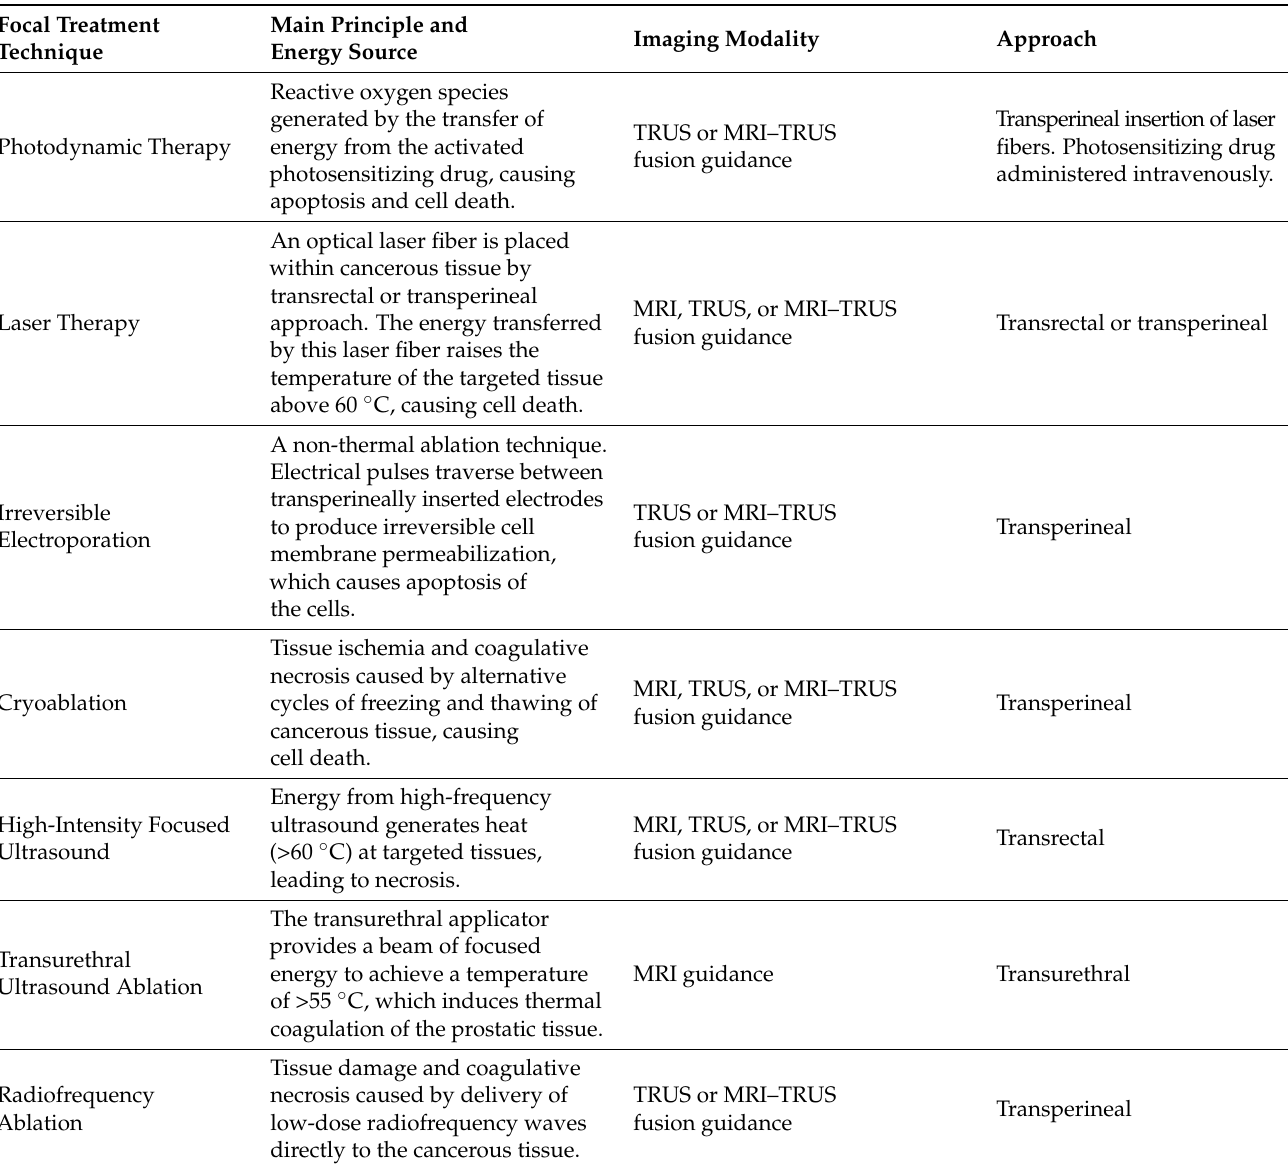
Table 3. Overview of image-guided PCa focal treatment